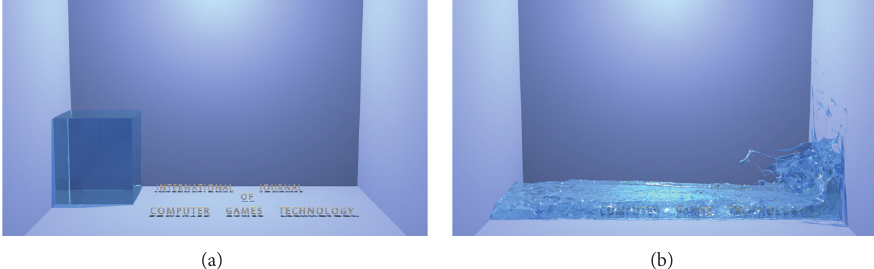
Figure 1: Corner dam break around static obstacles, 500 k fluid particles. Compared with standard weakly compressible smoothed particles hydrodynamics (WCSPH), our approach can achieve similar visual results at a higher efficiency.